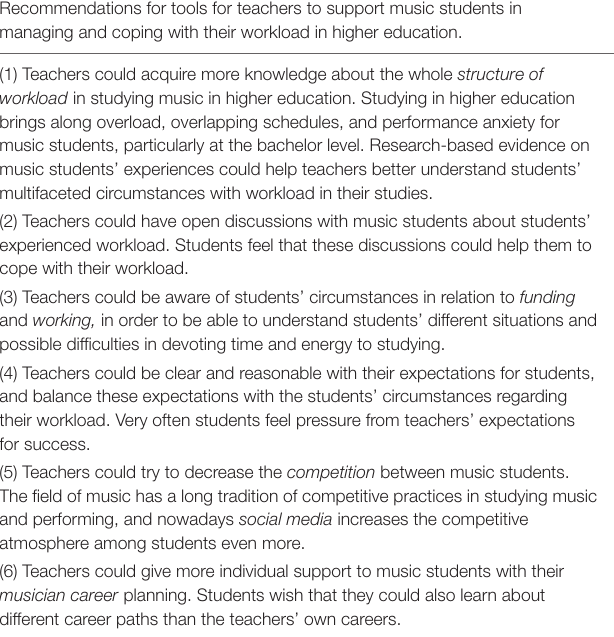
TABLE 3 | Structure of music students’ workload and tools for teachers. Recommendations for tools for teachers to support music students in managing and coping with their workload in higher education.